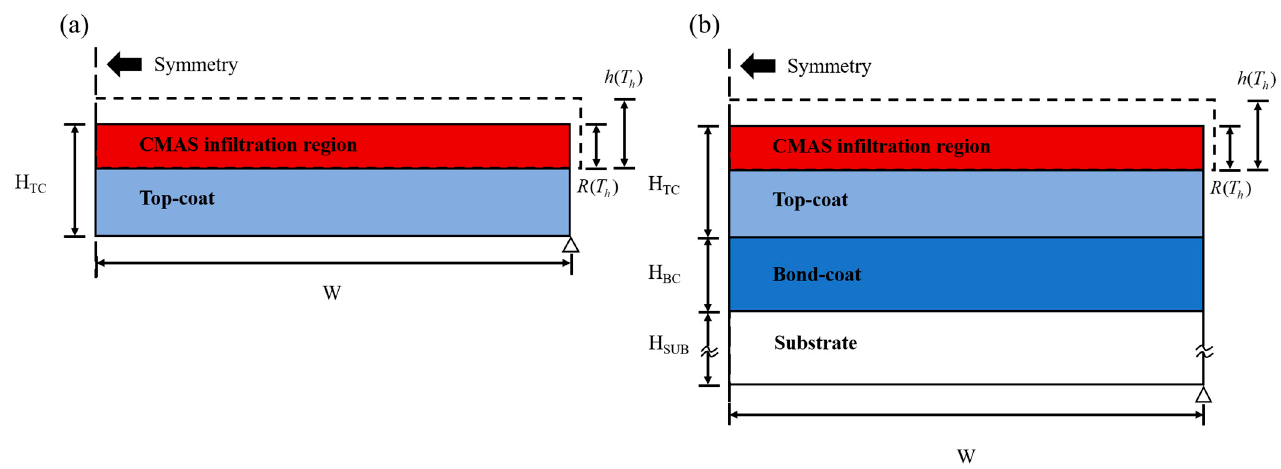
Figure 4. Schematic view of two finite element models: ( a ) model of free-standing YSZ covered by dynamic CMAS infiltration; ( b ) model of TBCs covered by dynamic CMAS infiltration.